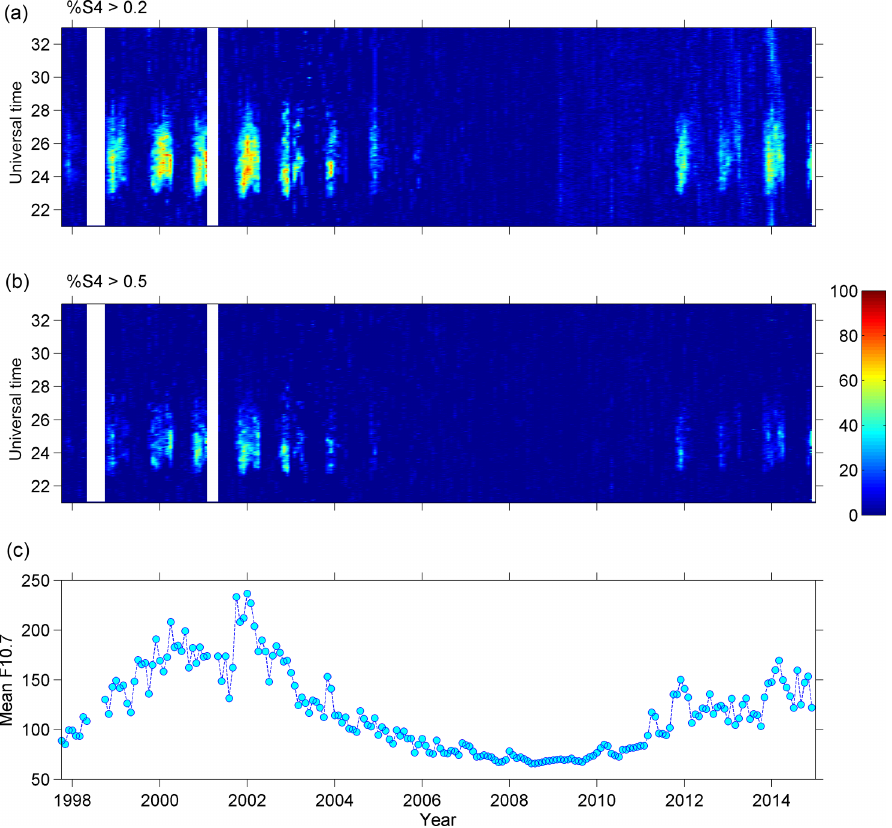
Figure 1. Percentage of scintillation occurrence at Cachoeira Paulista as a function of Universal Time (UT = LT + 3h) from September 1997 to November 2014 for two threshold levels of the S 4 scintillation index; S 4 > 0 . 2 in panel ( a ) and S 4 > 0 . 5 in panel ( b ). The monthly mean F10.7cm solar flux is shown in panel (c)